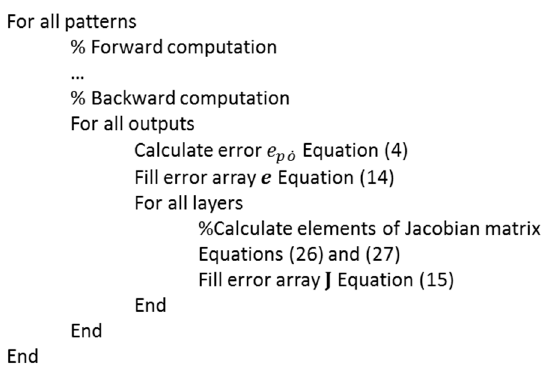
Figure 3. Pseudocode for Jacobian matrix.